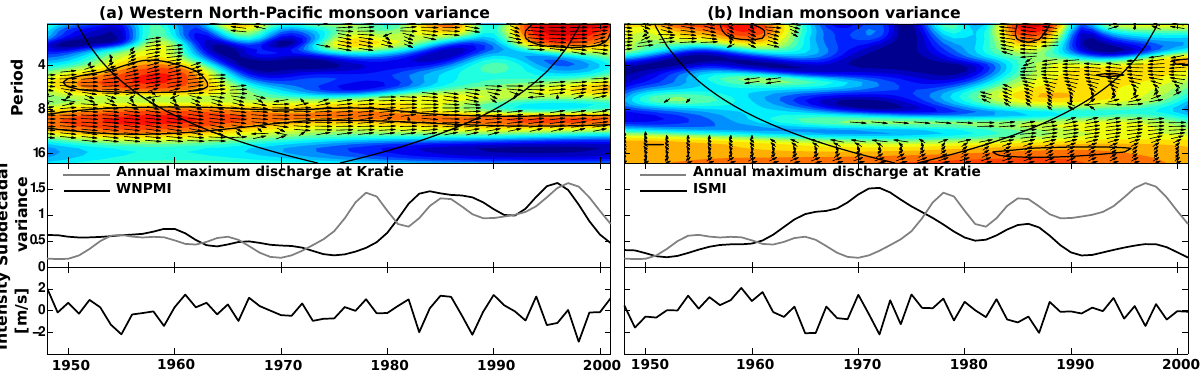
Fig. 4. (a) Phase coherence between the WNPM index and annual maximum discharge at Kratie (top). The y-axis shows the period of the oscillation and the x-axis the year. Warm colors represent high coherence between the two signals. Significant periods and years are surrounded by a black contour. The arrows show the phase between the two signals: arrow pointing to the right means 0 ◦ . The centre panel shows the 1 to 10yr moving variance as given by the Morlet wavelet for the same variables. The lower panel is the monsoon index time series. (b) Same as in (a) , but for the IM